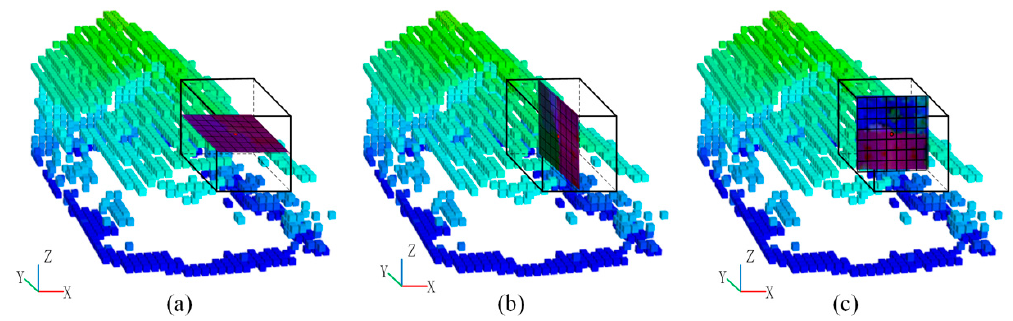
Figure 4. Multi-view feature maps: ( a ) feature map with view of X-Y plane, ( b ) feature map with view of Y-Z plane, ( c ) feature map with view of X-Z plane.